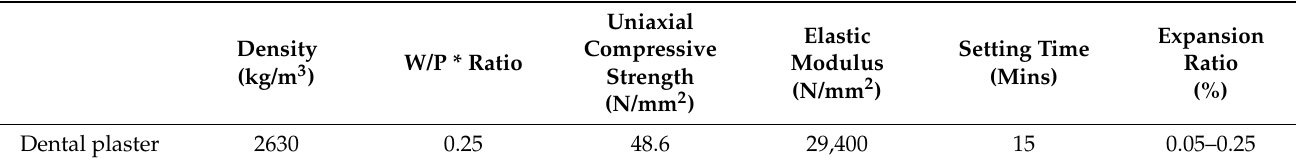
Table 1. Properties of the dental plaster used in this